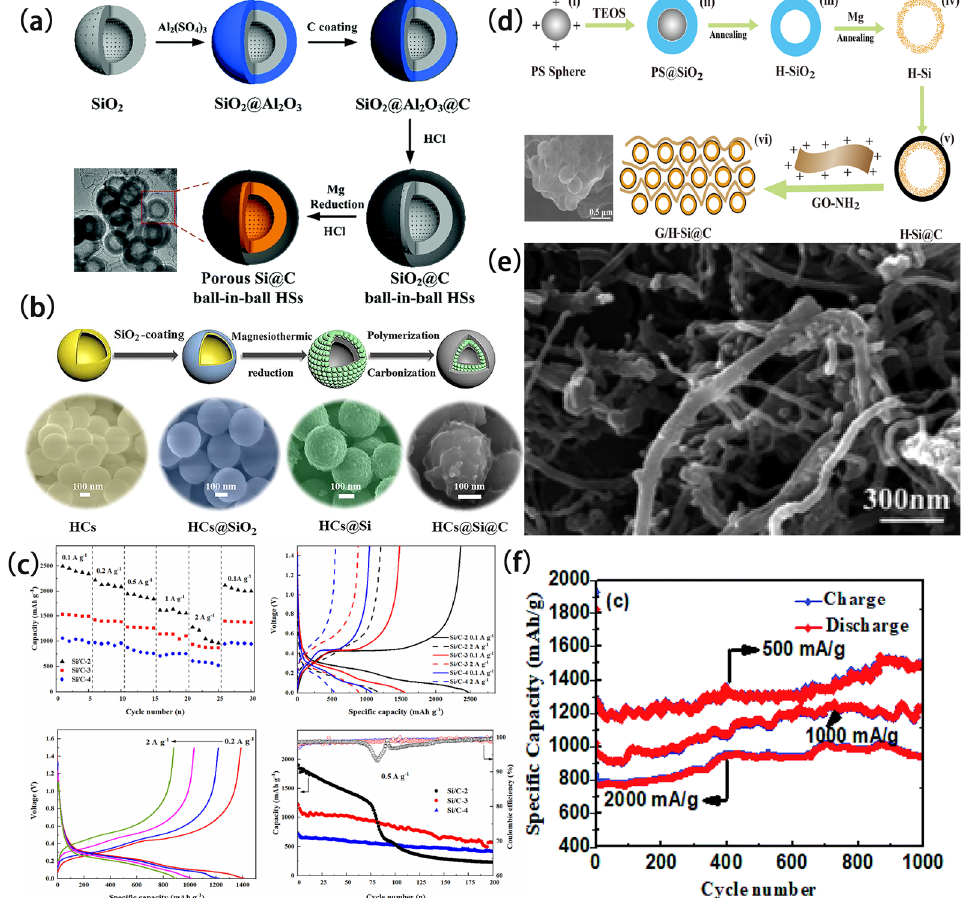
Figure 4. ( a ) Schematic fabrication process of porous Si@C ball-in-ball hollow spheres. Reproduced with permission [95]. Copyright 2018, Royal Society of Chemistry. ( b ) Schematic illustration of the synthesis processes of hollow carbon spheres (HCs)@Si@C “hollow triple-layer puff” structure. Reproduced with permission [97]. Copyright 2019, ACS Publications. ( c ) Rate capability, discharge- charge curve and cycling performance of different SiC hybrids. Reproduced with permission [98].